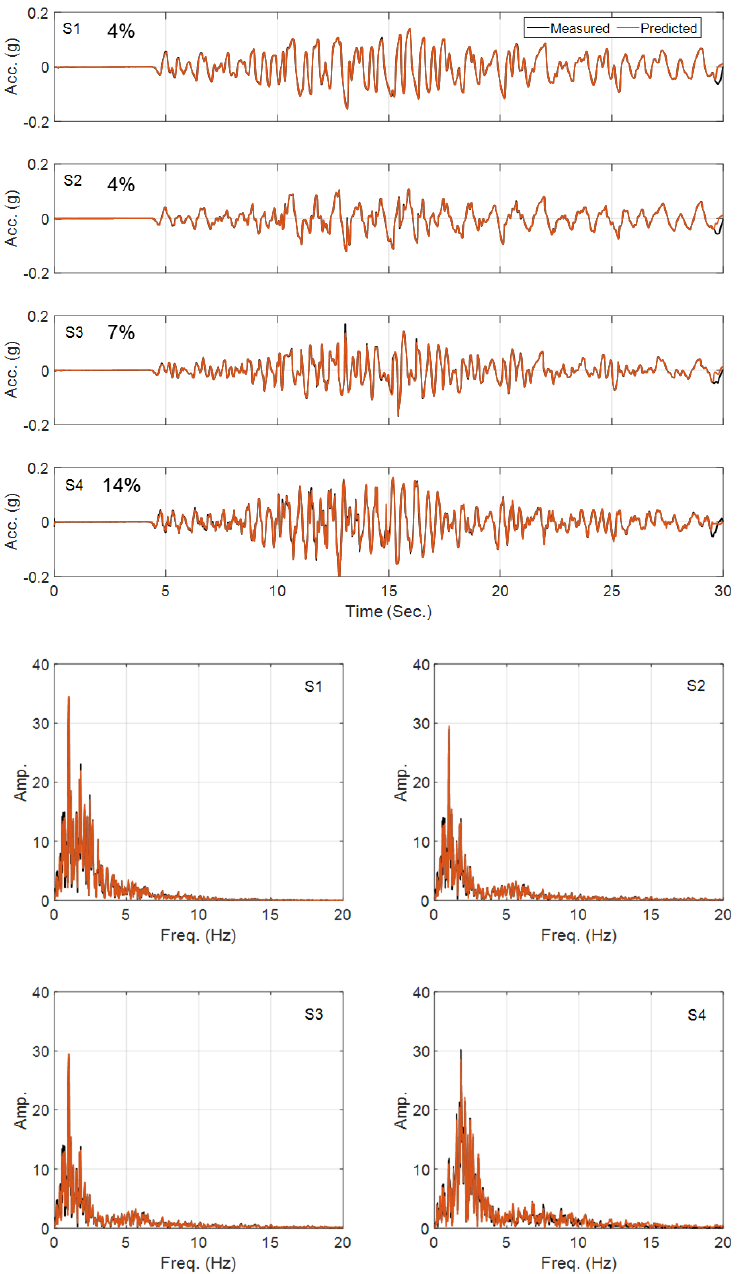
Figure 11. Time- and frequency-domain comparison between the measured and predicted acceler- ation responses in Case Study